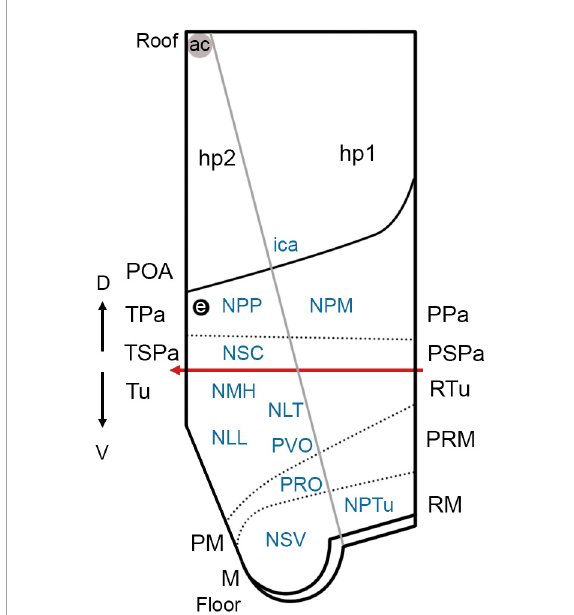
FIGURE8 Simplified view of the prosomeric model (only the secondary prosencephalon is represented) in Scyliorhinus canicula (based on the schematic representation of the updated prosomeric model by Puelles and Rubenstein, 2015) and main cell masses harbored in each hypothalamic domain. The red line represents the alar-basal boundary (rostral is to the left). For abbreviations, see